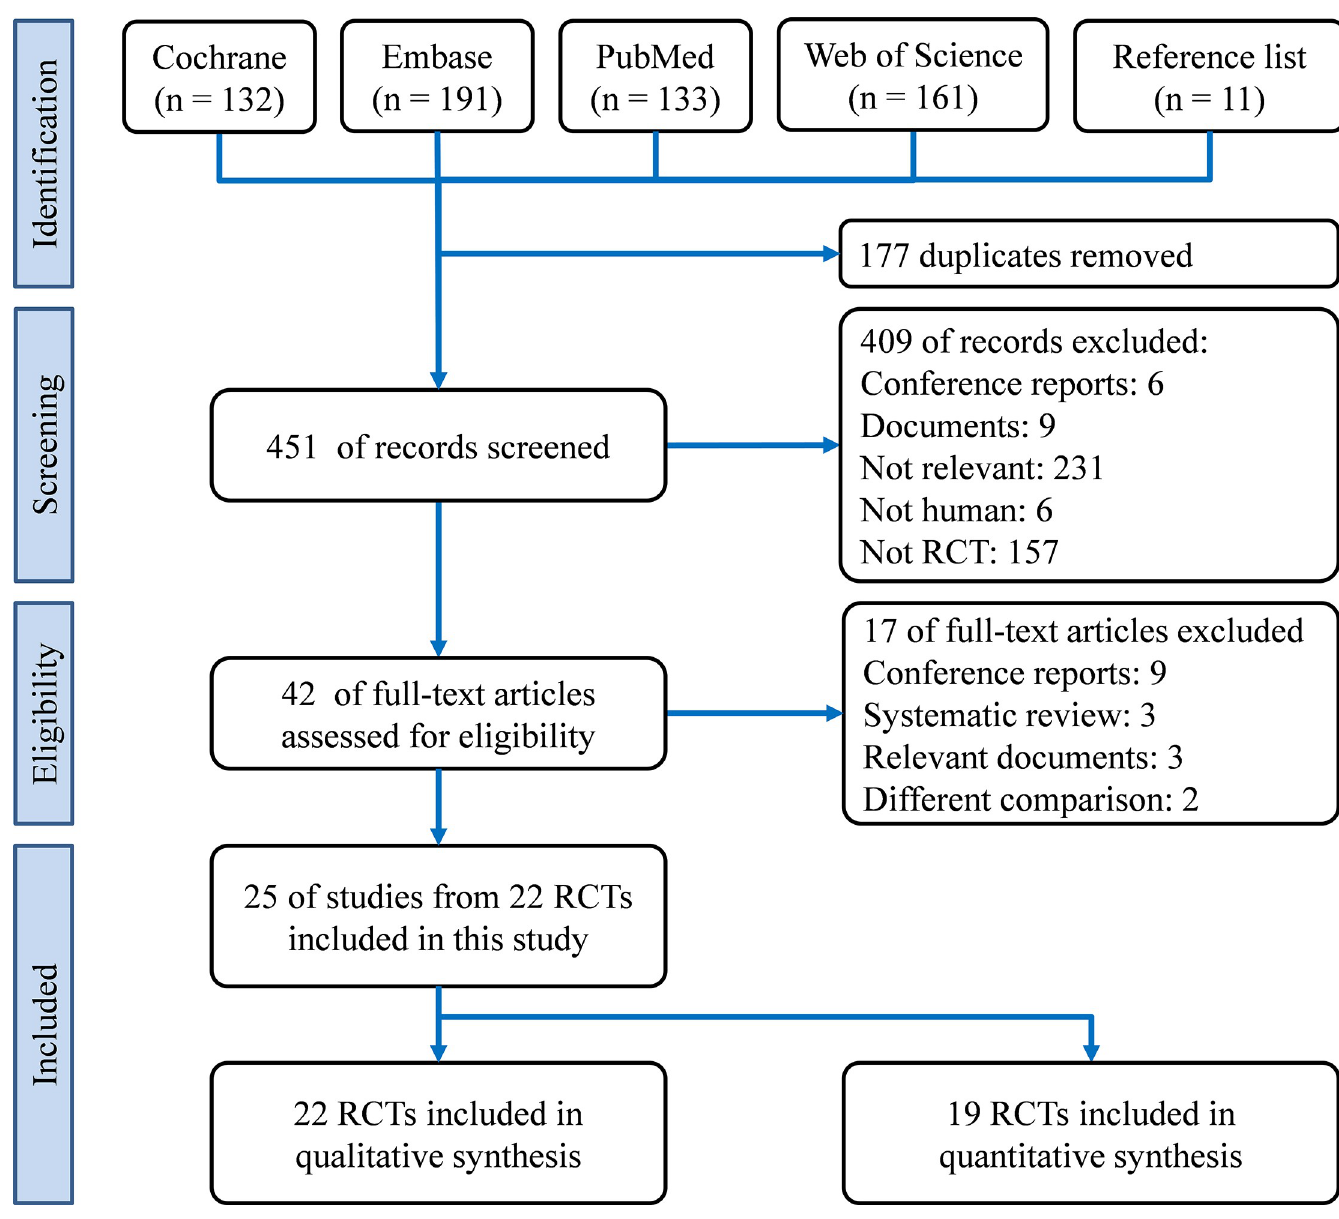
Fig 1. Preferred reporting items for systematic reviews and meta-analyses (PRISMA) flow diagram of study identification